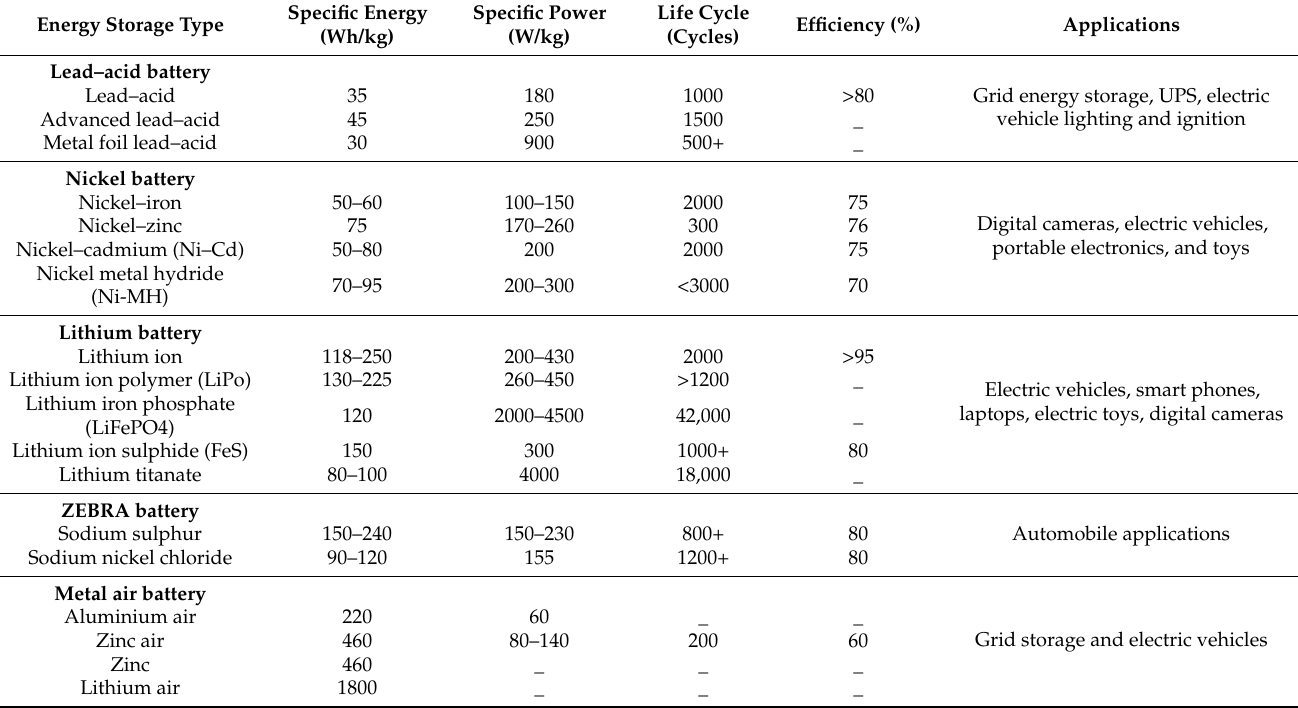
Table 4. Lifespans, characteristics, and applications of commonly used energy storage batteries